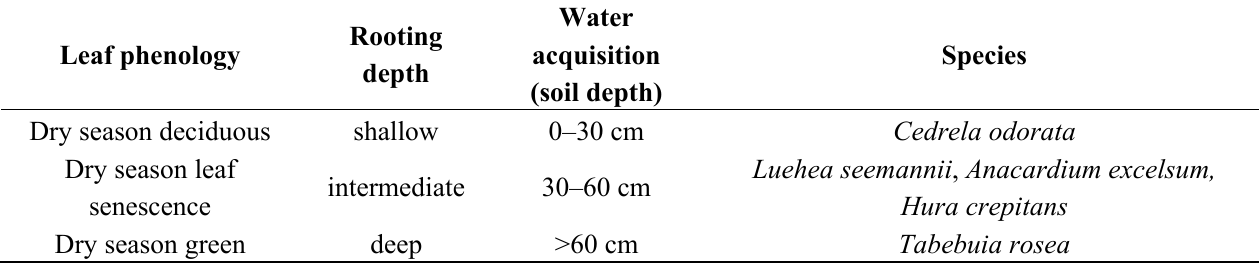
Table 2. Overview of the classification of species following different behavior in the seasonal leaf phenology and soil water uptake pattern (after